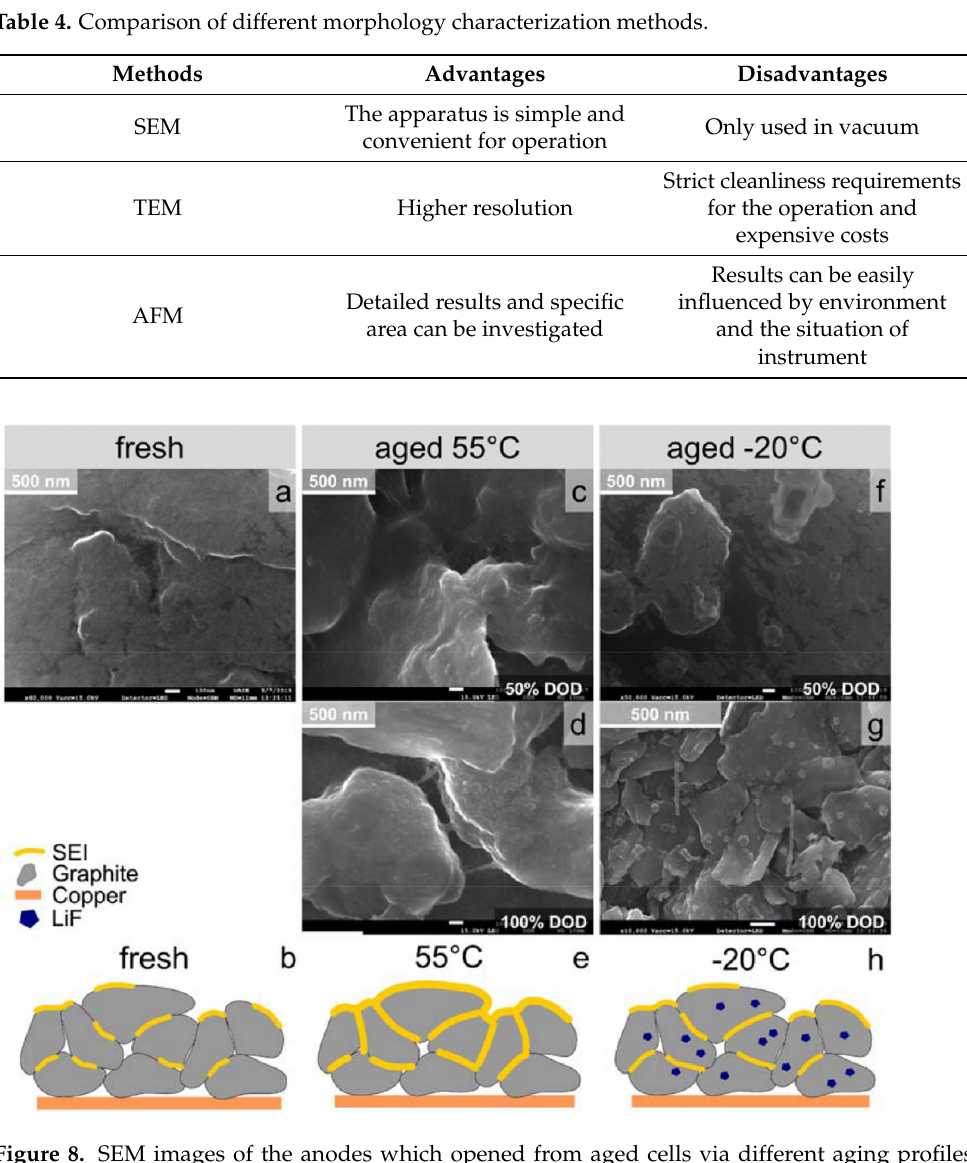
Figure 8. SEM images of the anodes which opened from aged cells via different aging profiles: ( a ) fresh cell; ( c ) 50% depth of discharge (DOD); ( d ) 100% DOD using AP 2 at 55 °C; ( f ) 50% DOD; ( g ) 100% DOD using AP 2 at − 20 °C; ( b , e , h ) show the fresh anode and the anode from cells aged at 55 °C and − 20 °C, respectively [64].